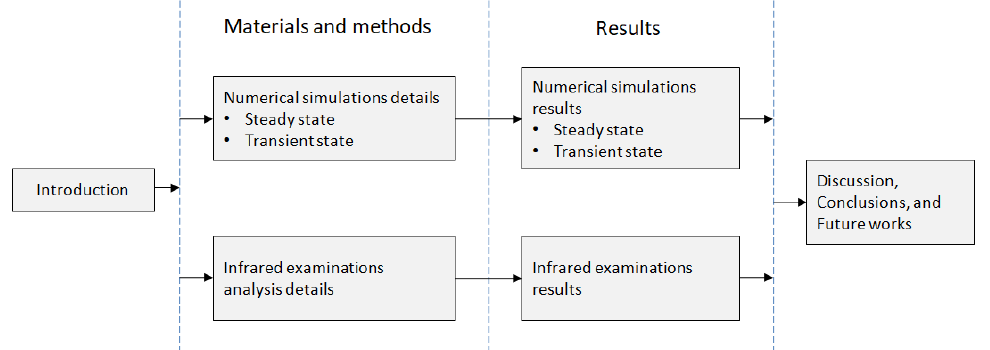
Figure 2. Flowchart followed in the exposition of the